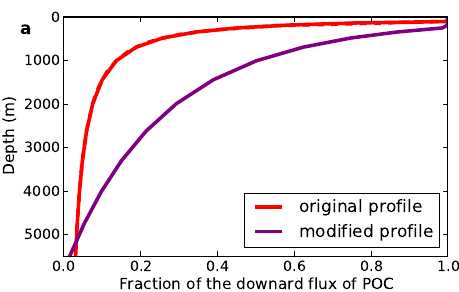
Figure 2. Fraction of particulate organic carbon (POC) which is transported downward at each level (the fraction not transported is